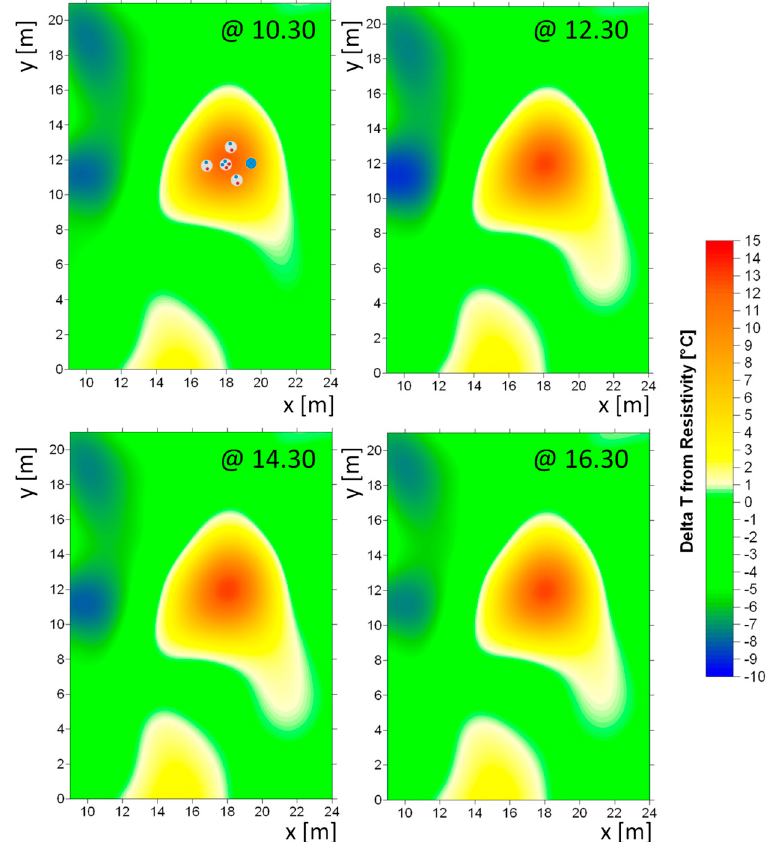
Figure 4. Temperature differences obtained from the interpretation of inverted resistivity data (Equation (3)) for four different time steps during the monitoring day. The location of BHEs is reported in the first panel.